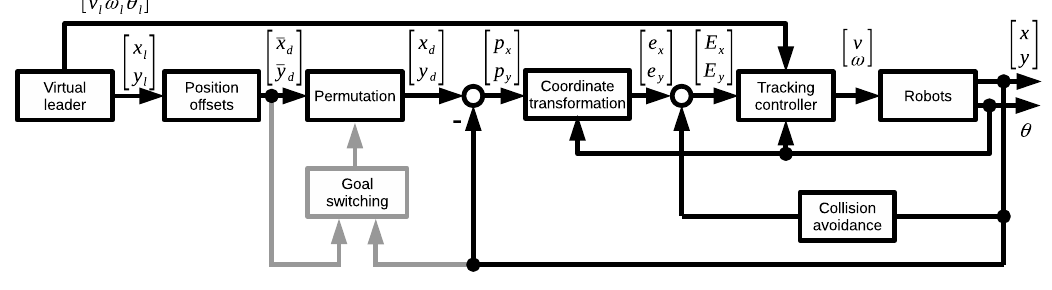
Figure 6. Control system with goal